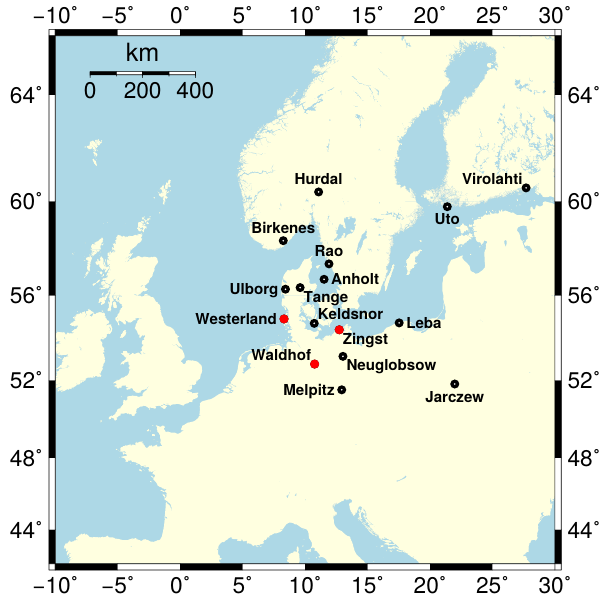
Figure 2. The EMEP stations chosen for the comparison to the CMAQ data. Red circles indicate the station data, which are plot- ted in Sect. 3.